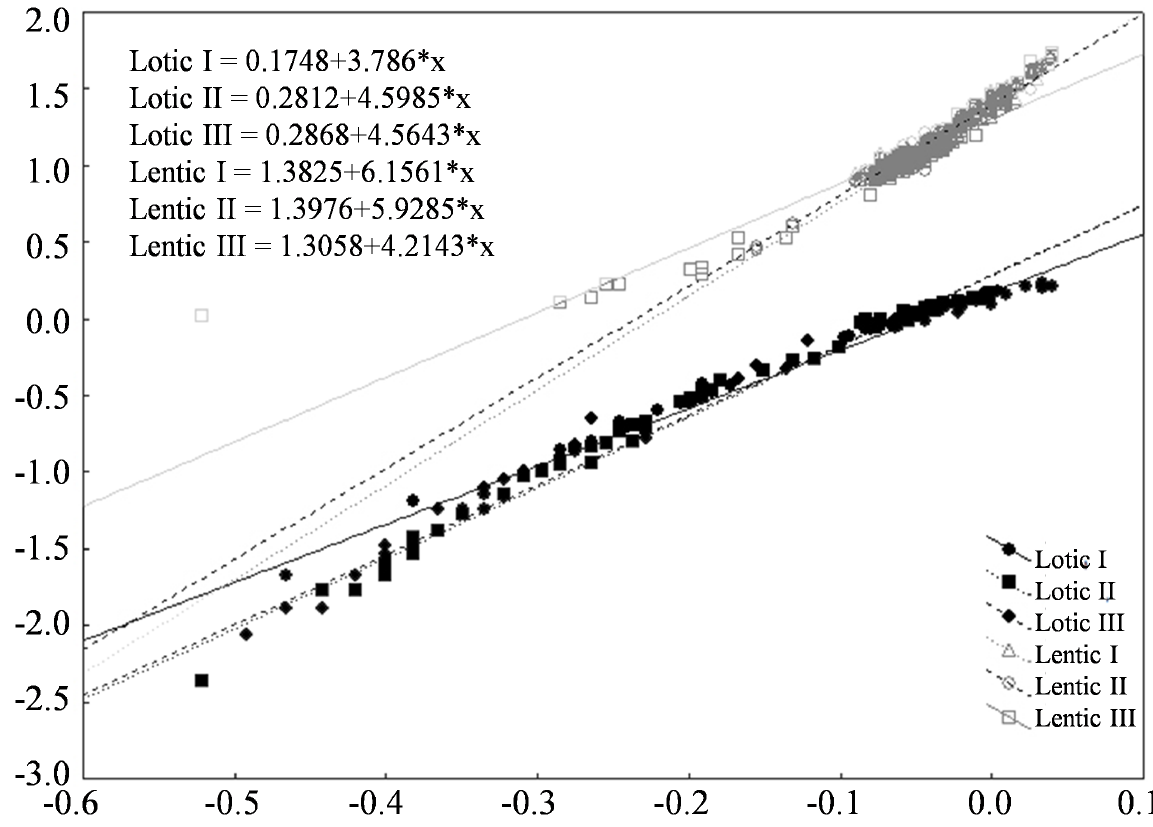
Figure 5. Adult and young proportion of Astyanax lacustris in lotic and lentic habitats of Chavantes Reservoir, Middle Paranapanema River. * = statistically significant differences based on the chi- square